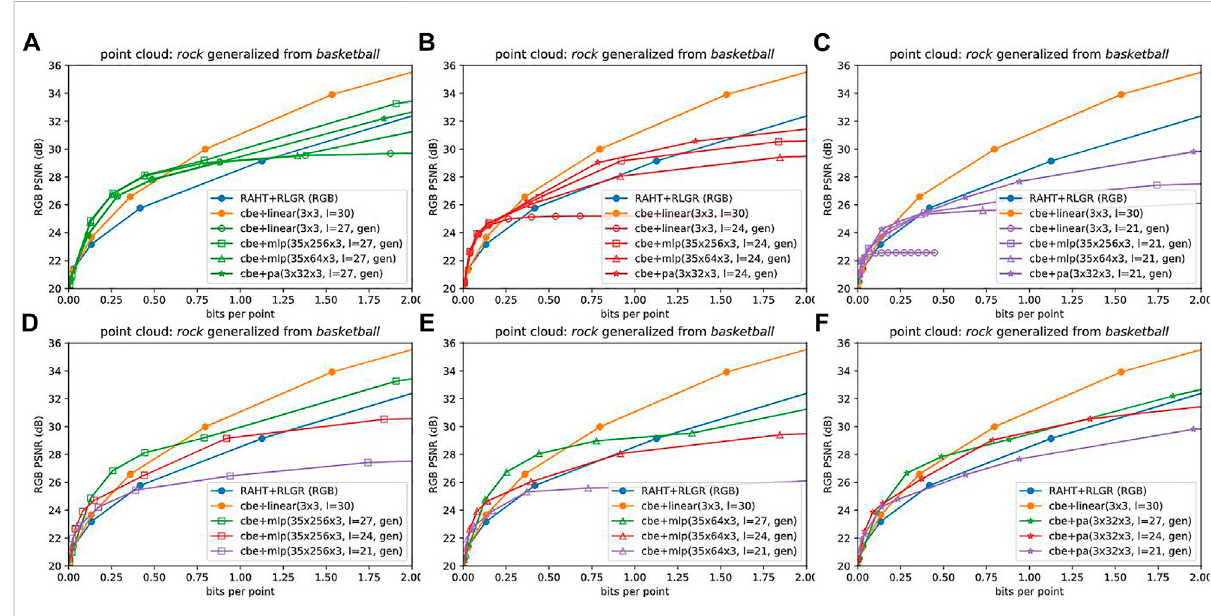
FIGURE 8 Coordinate Based Networks with generalization, by level (A – C) and by network (D – F) . CBNs that are generalized (i.e., pre-trained on another point cloud) are able to outperform the baselines at low bit rates.